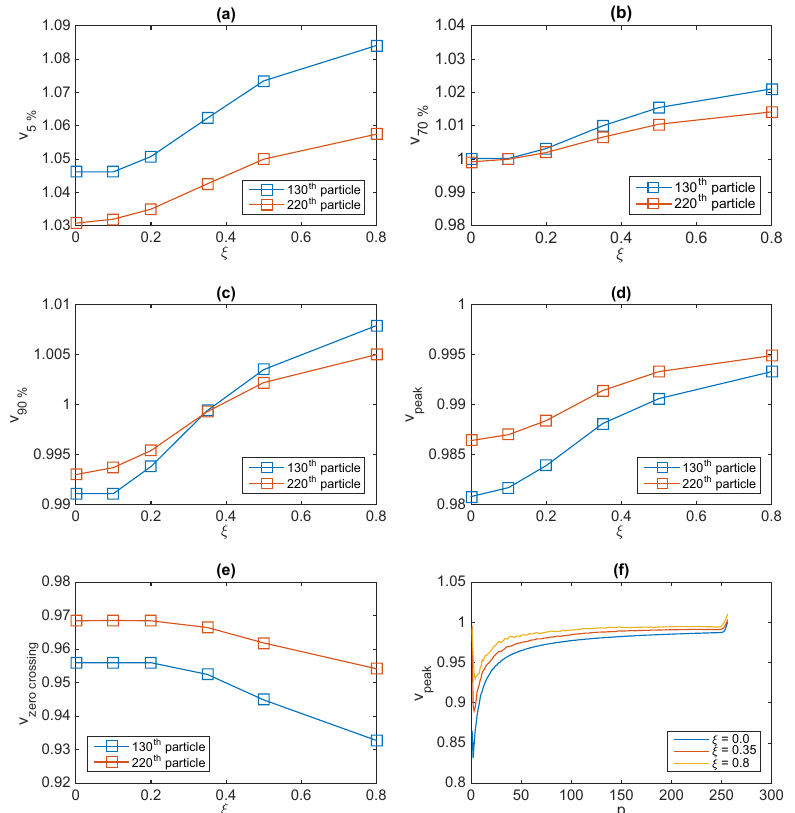
Figure 7. Coherent wave velocities determined through velocity picking. The peak of the coherent wave packet’s velocity (d) and the rising part of the packet (a, b, c) as well as the falling part (e) are taken into consideration. Panel (f) displays the peak velocity for all the particles in a granular chain with different ξ . Note that (a, b, e) have a different axis range as (c, d)